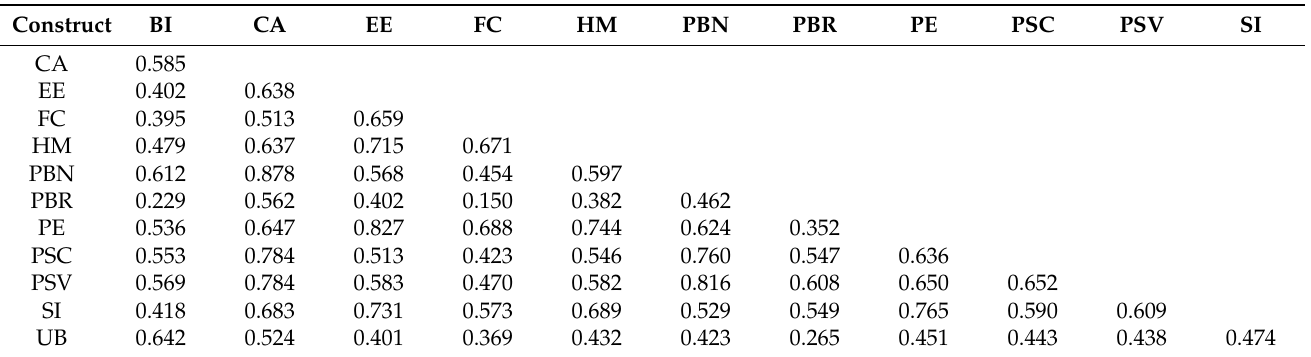
Table 8. The Heterotrait–Monotrait (HTMT)